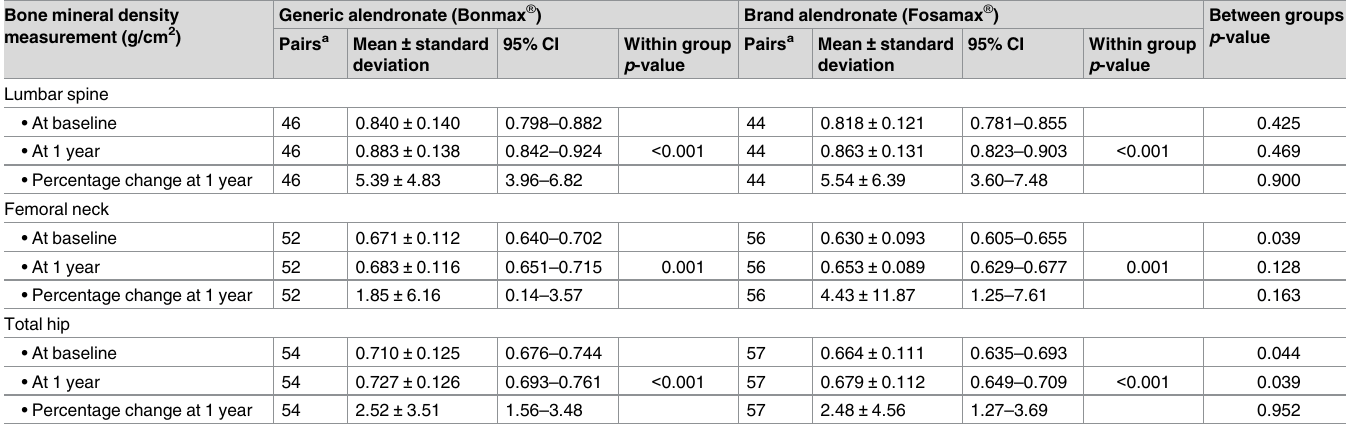
Table 2. Changes in bone mineral density after one year of treatment with generic or brand alendronate. Bone mineral density measurement (g/cm 2 )